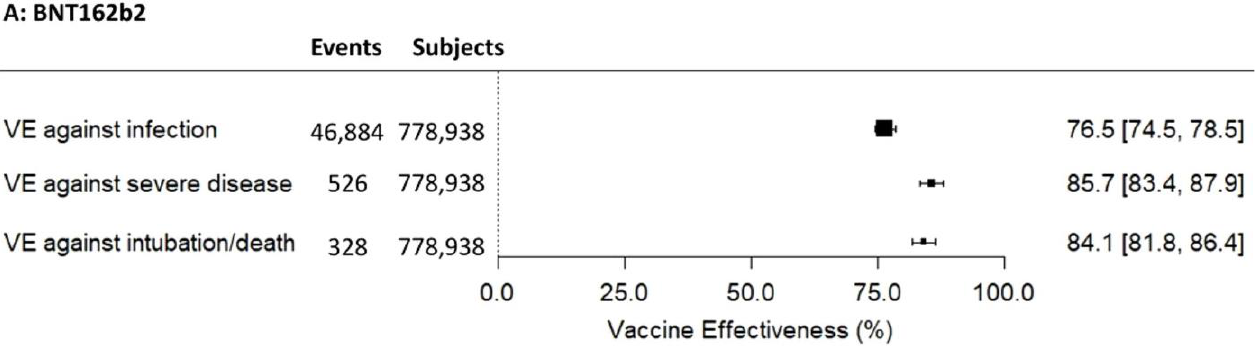
Figure 2. Vaccine effectiveness (VE) of the booster dose against SARS-CoV-2 infection, severe COVID-19, and intubation/death related to COVID-19 in patients vaccinated with BNT162b2 ( A ) and mRNA-1273 ( B ). 4. Discussion The key findings of the present study strongly suggest that a booster dose of mRNA- based vaccines may reduce the risk of SARS-CoV-2 infection, severe COVID-19, and intu- bation/death from COVID-19. In fact, the booster dose with mRNA vaccines was associ- ated with at least 74% vaccine effectiveness against infection, and this protection increased when considering more serious outcomes such as severe COVID-19, intubation and death. These results are consistent with those found in other studies. In a study conducted in Qatar, Abu-Raddad et al. [27] observed a booster-dose vaccine effectiveness of 86.1% against symptomatic Omicron infection, which is relatively higher than our results. Simi- larly, a study carried out in the United Kingdom has reported a vaccine effectiveness of the booster dose of 73.9% against SARS-CoV-2 infection, consistent with our 78% [28]. However, the small variations in results between studies could be attributed to factors such as the prevalence of different COVID-19 variants, prevention strategies and popula- tion characteristics (e.g., mask-wearing was mandatory in Italy but not in the UK) [29,30]. In Israel, vaccine effectiveness against severe disease and death from COVID-19 was found to be 92% and 90%, respectively, confirming the soundness of our results against severe outcomes [31]. The importance of the previously reported findings becomes evident if we consider that, according to the previous studies, VE decreases over time after the completion of the main cycle because of the waning of immune protection; thus, the following booster dose could provide enhanced protection [31,32]. Moreover, similarly to the results of the Bar-On et al. [33] study, our vaccine effec- tiveness against COVID-19 infection was about 74% during the period of Omicron variant